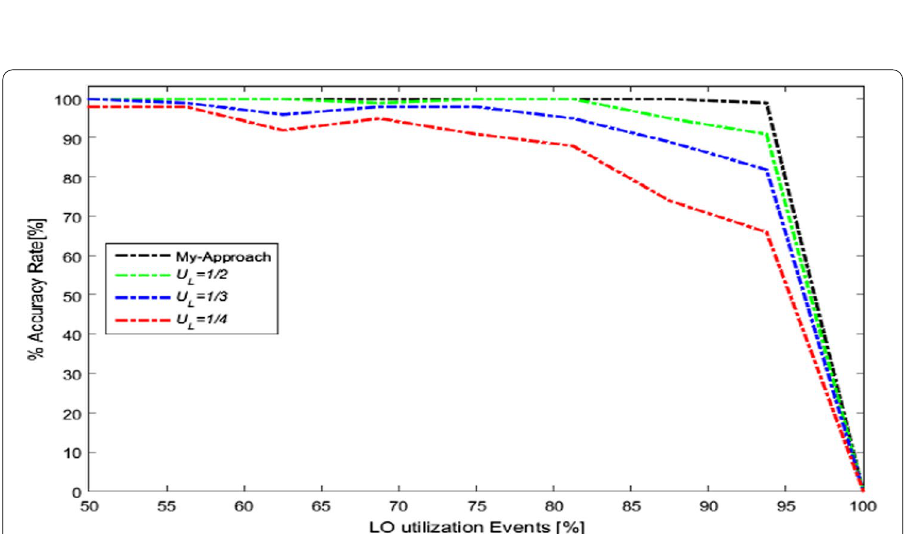
Fig. 5 Results of the accuracy of sending and receiving data from sensors to the hospital in the proposed method using 20 sensors with that of other methods